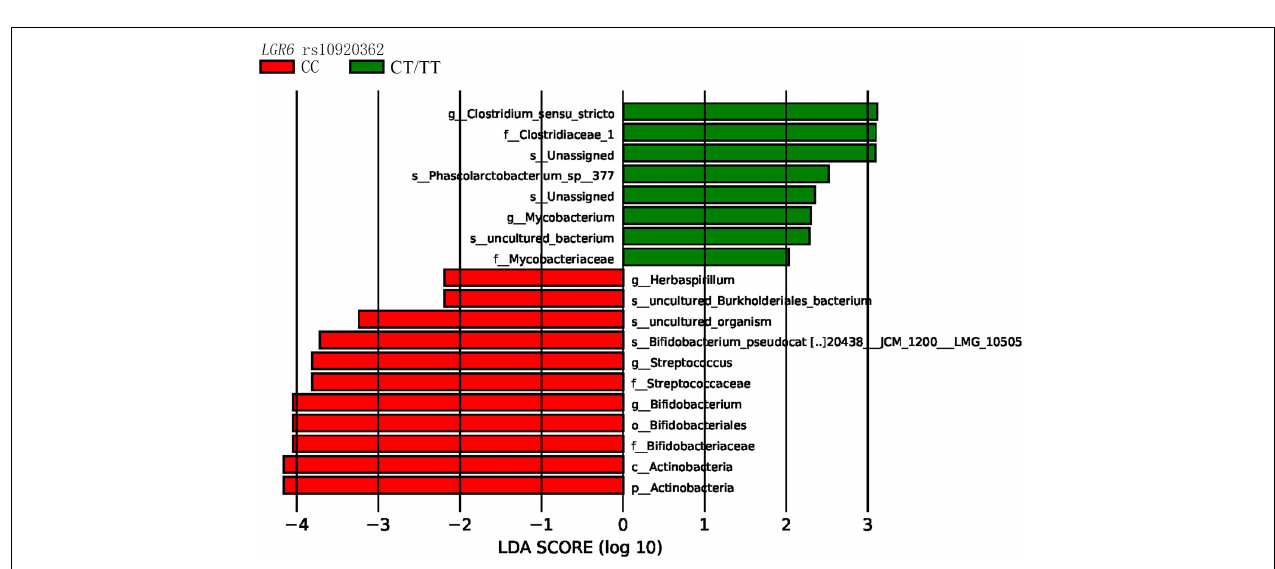
FIGURE 3 | LEfSe indicating differences in the bacterial taxa in different rs10920362 genotypes (p, phylum; c, class; o, order; f, family; g, genus; and s, species), only the taxes having a P < 0.05, and LDA value > 2 are shown in the